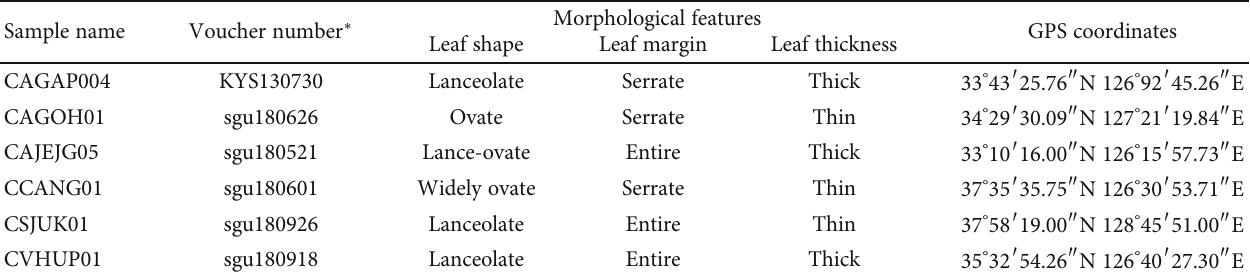
Table 1: List of six Chenopodium album samples used in this study.